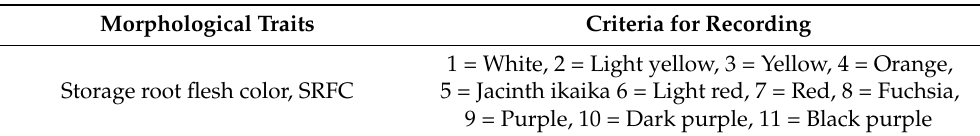
Table 1. Morphological traits and their criteria for sweet potato. Morphological Traits Criteria for Recording Storage root flesh color,